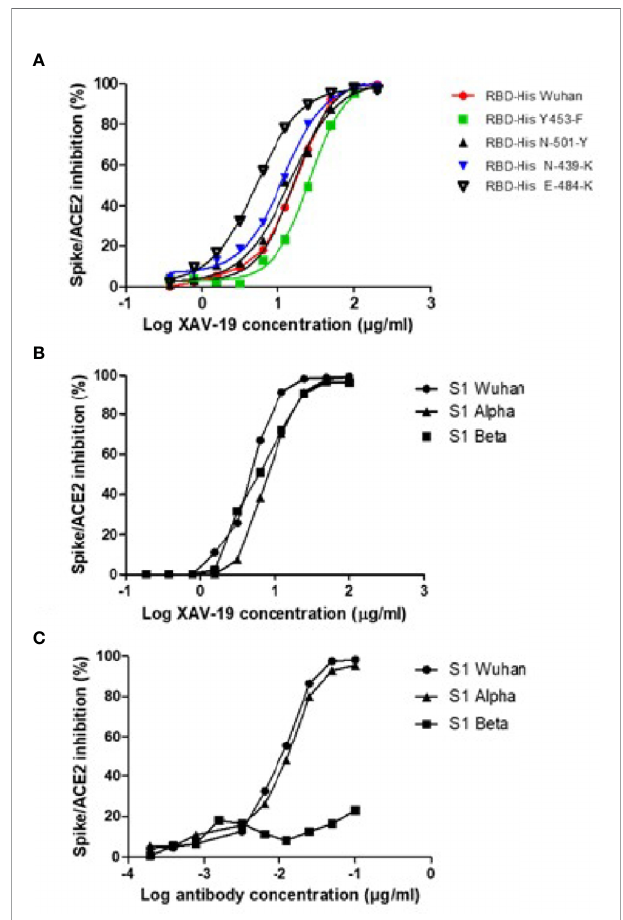
FIGURE 3 | Neutralization assay in the ELISA format: assessment of SARS- CoV-2 Spike/ACE-2 interaction and its anti-RBD antibody-mediated inhibition. Spike-HIS containing the indicated mutations (A) or grouped mutations corresponding to the Alpha and Beta variants (B, C) was immobilized on plastic, and binding of recombinant human ACE2-Fc was revealed with a secondary antibody against Fc. 100% inhibition represents absence of Spike/ ACE-2 interaction. (A, B) Means of triplicate measurements run in a single experiment assessing XAV-19 at the indicated concentration. (C) Means of triplicate measurements run in a single experiment assessing bamlanivimab at the indicated